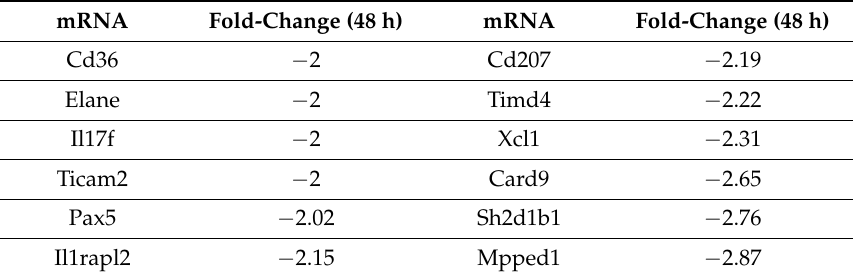
Table 8. Downregulated mRNAs in ZIKV-infected